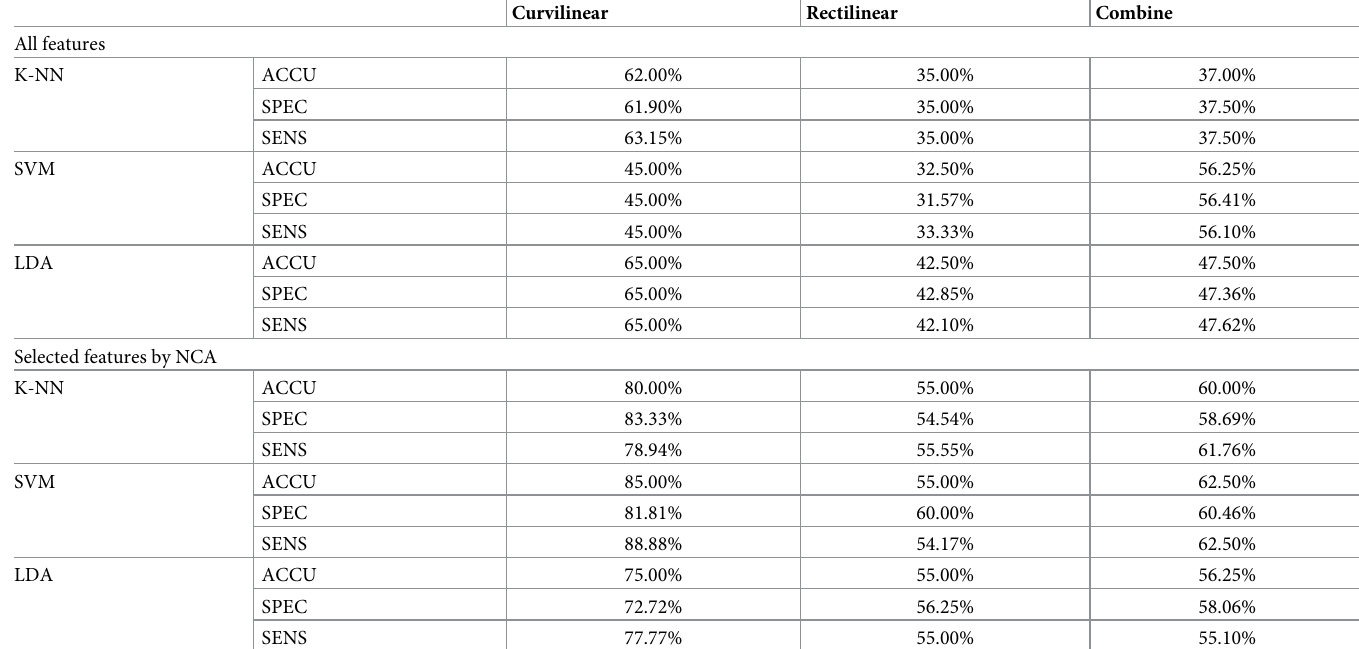
Table 3. Classification performance for each